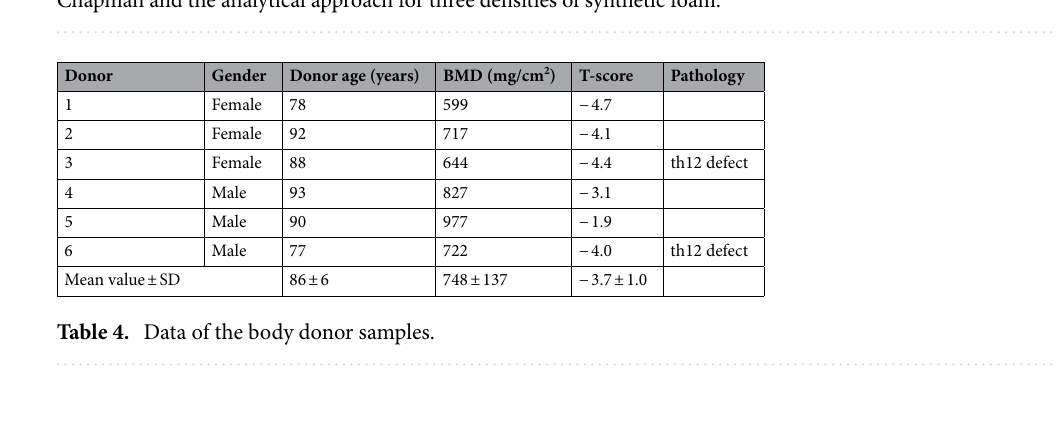
Figure 7. Comparison of the experimental pull-out strengths (in N) with the calculated values according to Chapman and the analytical approach for three densities of synthetic foam.